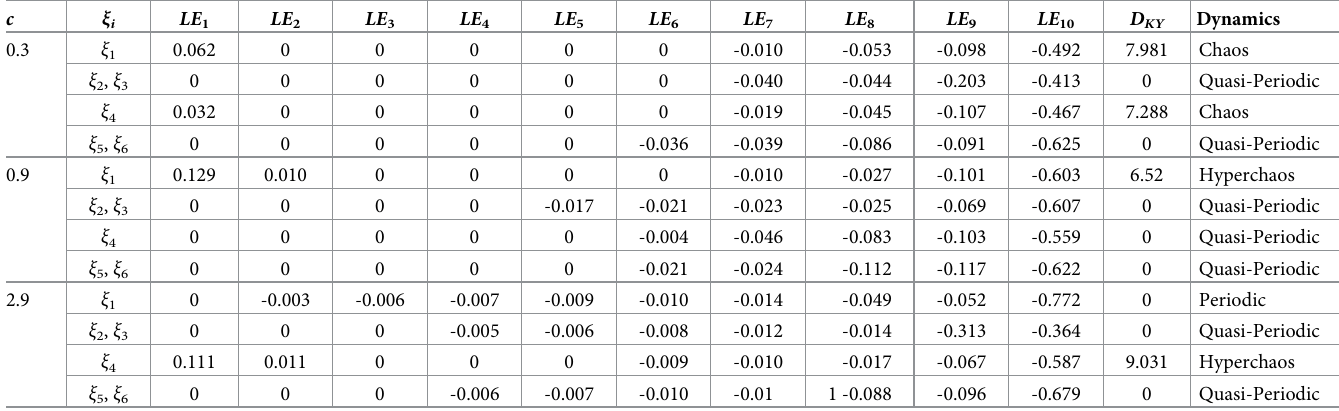
Table 8. Lyapunov exponents, Kaplan-Yorke dimensin and dynamics of system (1) coexisisting attractors with parameter c